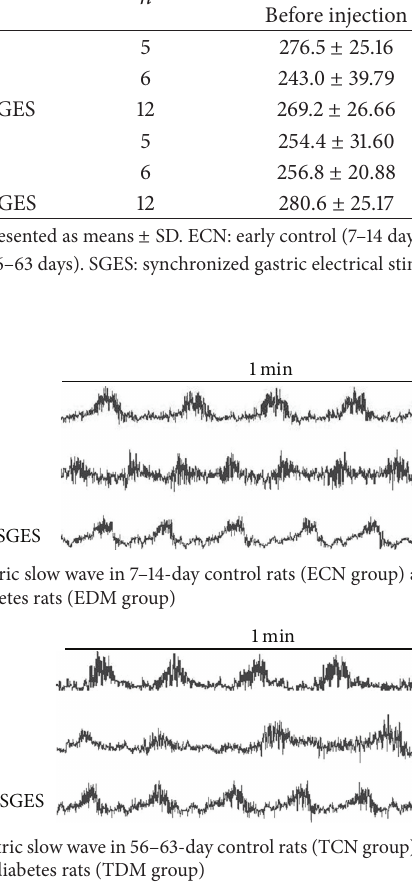
Table 1: Blood glucose and body weight in controls and diabetes mellitus rats. Body weight, g Blood glucose, mmol/L Group 𝑛 Before injection After injection Before injection After injection